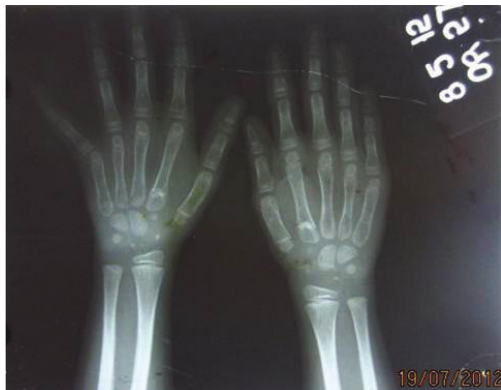
Figure 6: Hand wrist radiograph.